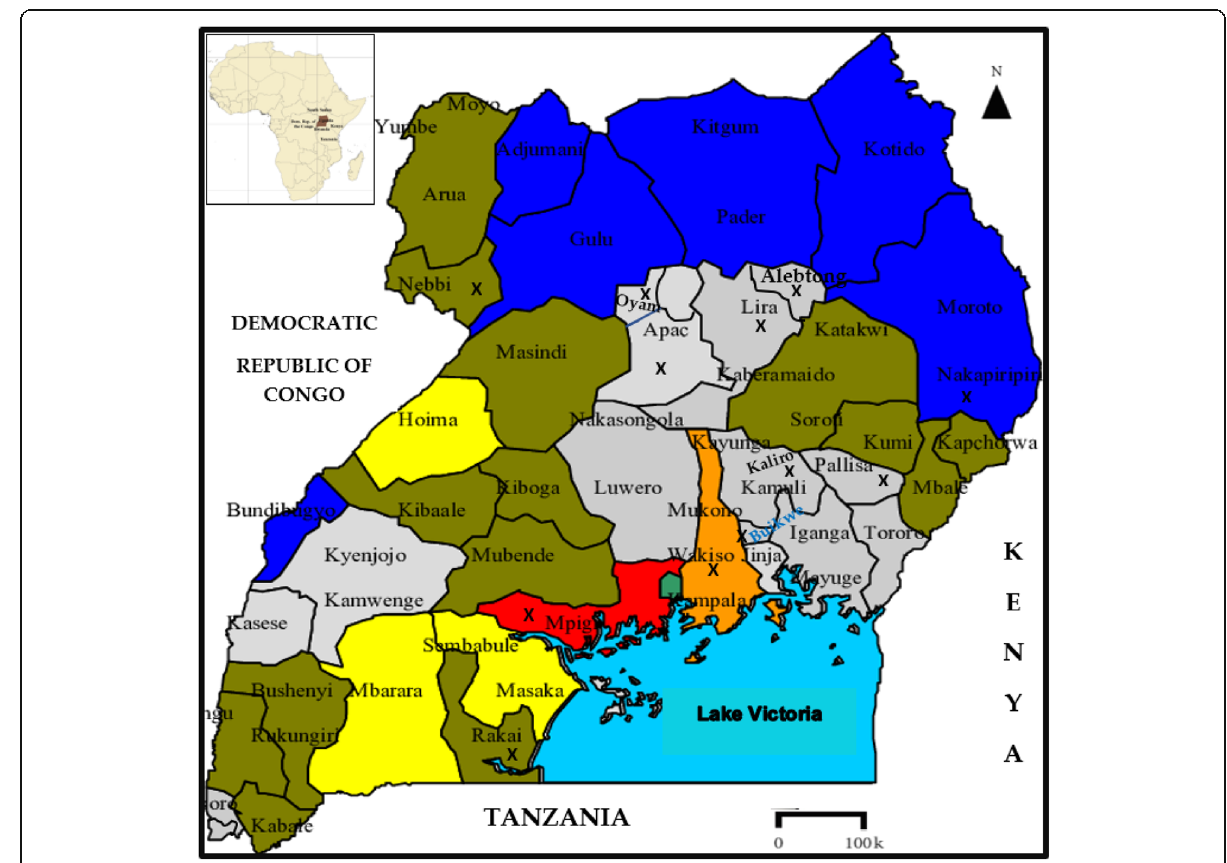
Fig. 1 Map of Uganda showing the location of the districts with reports of ethnobotanical surveys (marked X). Inset is the location of Uganda on the African